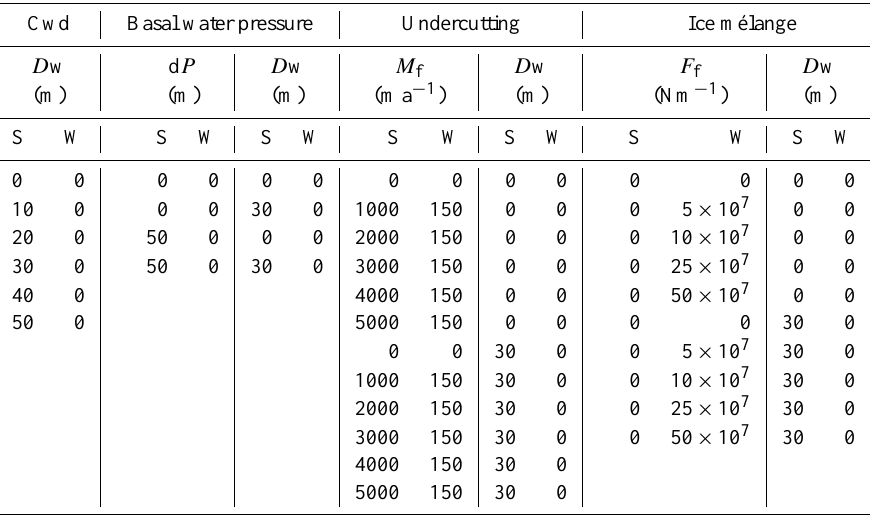
Table 1. Full list of experiments performed, arranged by results section. S and W refer to summer and winter values. D w is the crevasse water depth (cwd), d P is the change in hydrostatic head applied to the basal water pressure, M f is the maximum melt rate applied at the calving face and F f is the force applied to the calving front over a vertical range of − 120 to 15ma.s.l. In ice mélange experiments where both the cwd and the backstress vary, the length of seasons in cwd and backstress do not match, meaning that there is also an autumn season where both the cwd and the backstress are set at